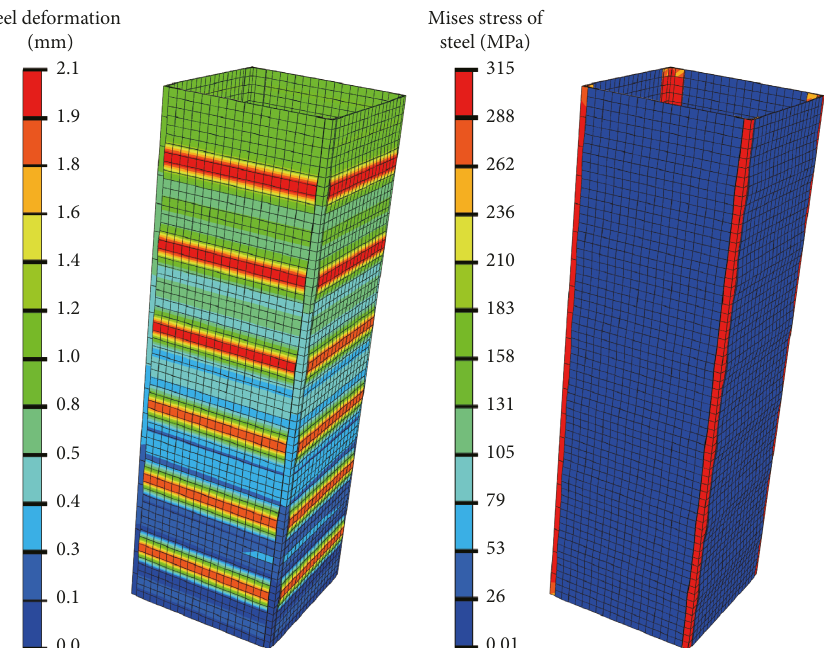
Figure 19: Deformation and stress of the L650 tube upon column failure.